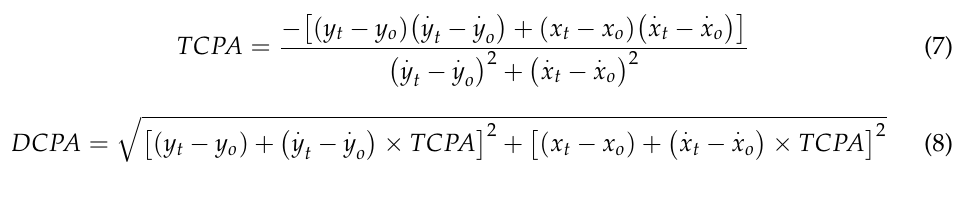
Figure 3. Diagram showing position of other ship relative to our own ship.